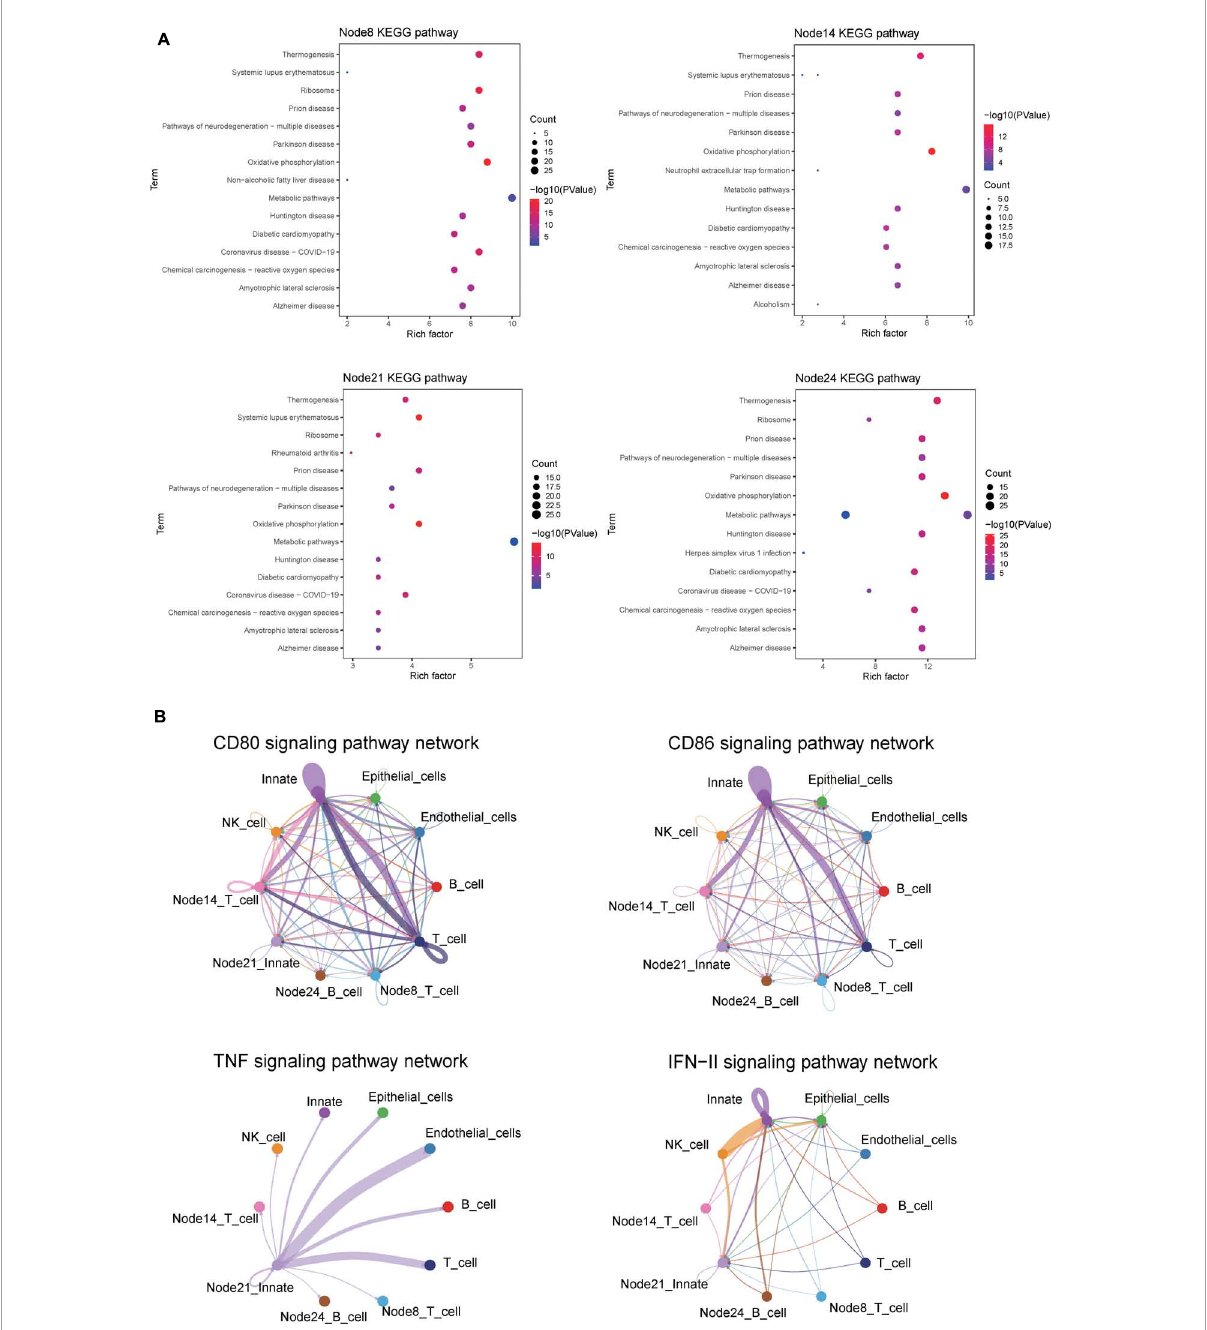
FIGURE9 CellChat and KEGG revealed critical pathways that influence the course of CD. (A) KEGG pathway enrichment analysis of four cell subsets of interest. Node8:CD16 + CD38 + CD4 + CXCR3 + CCR6 + naive T cells; Node14: HLA-DR + CD38 + IFN γ + TNF + EM T cells; Node21:CD14 + + CD11C + IFN γ + monocyte; HLA-DR + IFN γ + naive B cells. (B) Circle plot showing the inferred CD80, CD86, IFN γ , and TNF signaling communication network among different cell subsets.